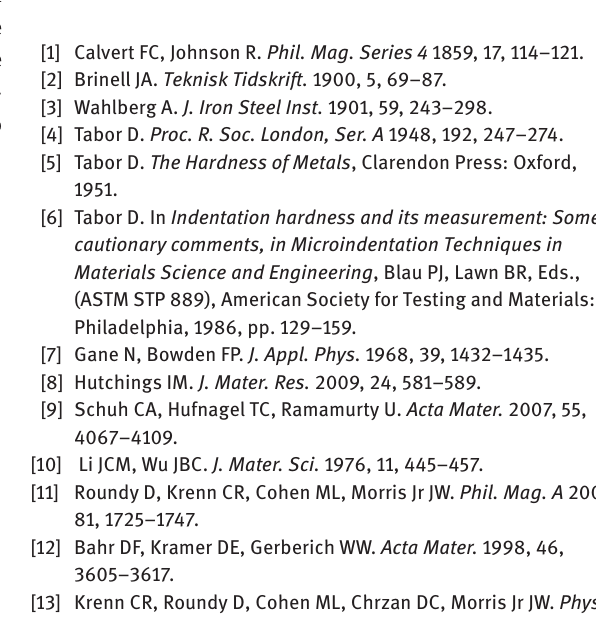
Figure 3: Bright-field XTEM image of a residual indent in unrelaxed a-si with 650 nm thickness